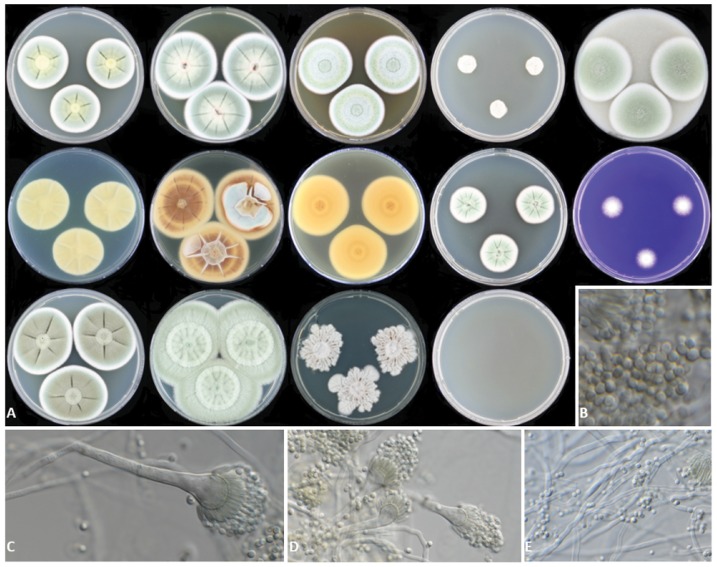
Aspergillus frankstonensis CBS 142233; CBS 142234.(A) Colonies grown at 25°C for 7 days, from left to right (top row) CYA, YES, MEA, CYAS, OA; middle row CYA reverse, YES reverse, MEA reverse, DG18, CREA; bottom CYA grown at 30°C, 37°C, 45°C, 50°C. (B) Conidia (C—D) Conidiophores (E) Hyphae.